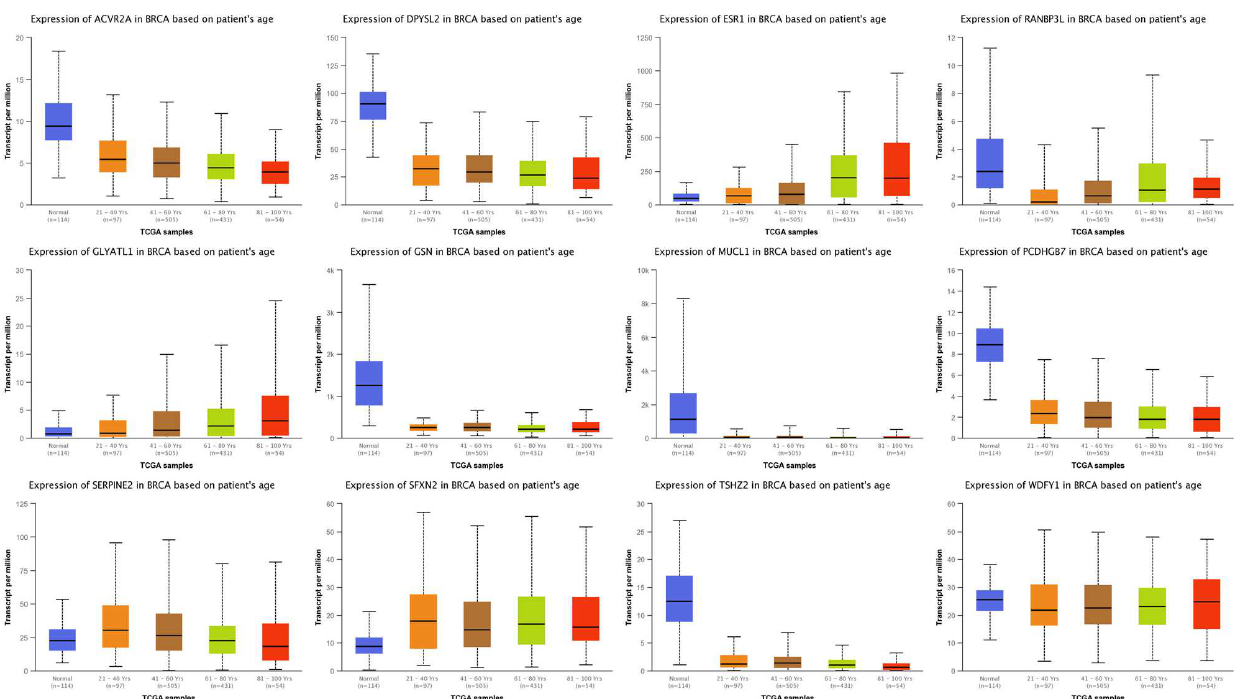
Figure 2. Validation of the differentially expressed genes by young-age breast cancer tissues using RNA-seq data from TCGA database. ACVR2A , SERPINE2 , and PCDHGB7 show upregulation in young-age breast cancer patients compared to old age patients. RANBP3L , GLYATL-1 , and ESR1 show down-regulation in young age patients compared to old age patients. p -values for each comparison are presented in Supplementary Table S1.